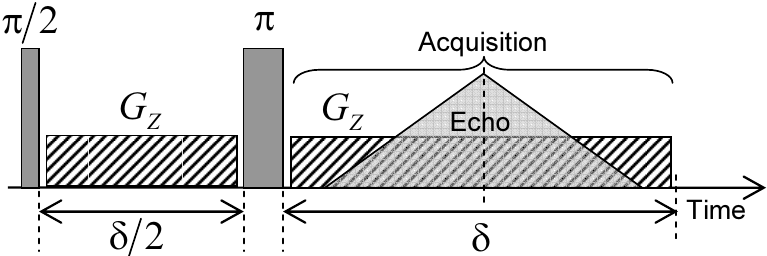
Figure 15. Schematic view of the pulse sequence used to create the water concentration profiles inside the compacted clay sample by magnetic resonance imaging (MRI) technique. Reprinted with permission from [29]. Copyright (2018) American Chemical Society.